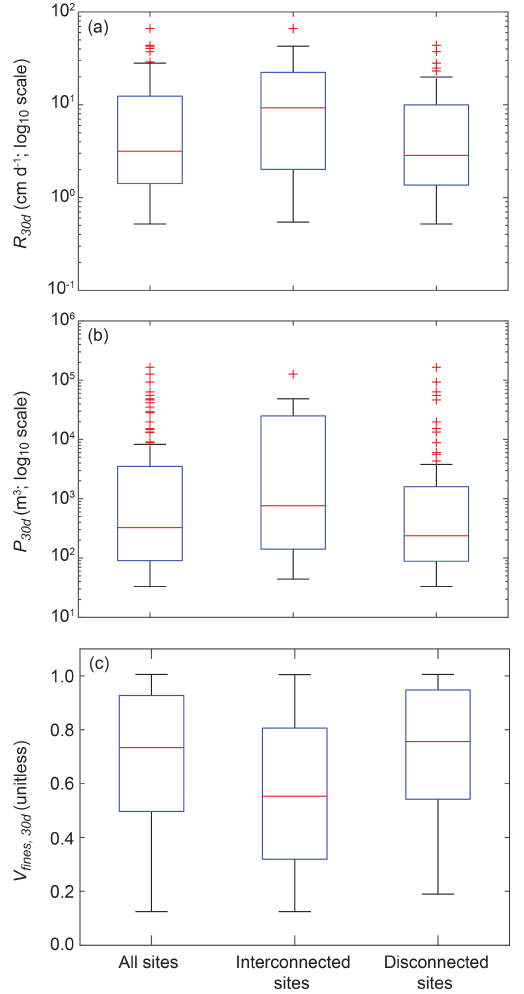
Figure 4. Box plots of the (a) 30d average recharge rate R 30d and (b) 30d pressure perturbation area of influence R 30d for all exploratory simulations ( n = 100). Additionally, sites were parsed according to whether there was a vertical interconnection of coarse- texture facies from the land surface to the initial water table depth (i.e., interconnected sites; n = 23) or whether sites did not have an interconnection of coarse-texture facies (i.e., disconnected sites; n =